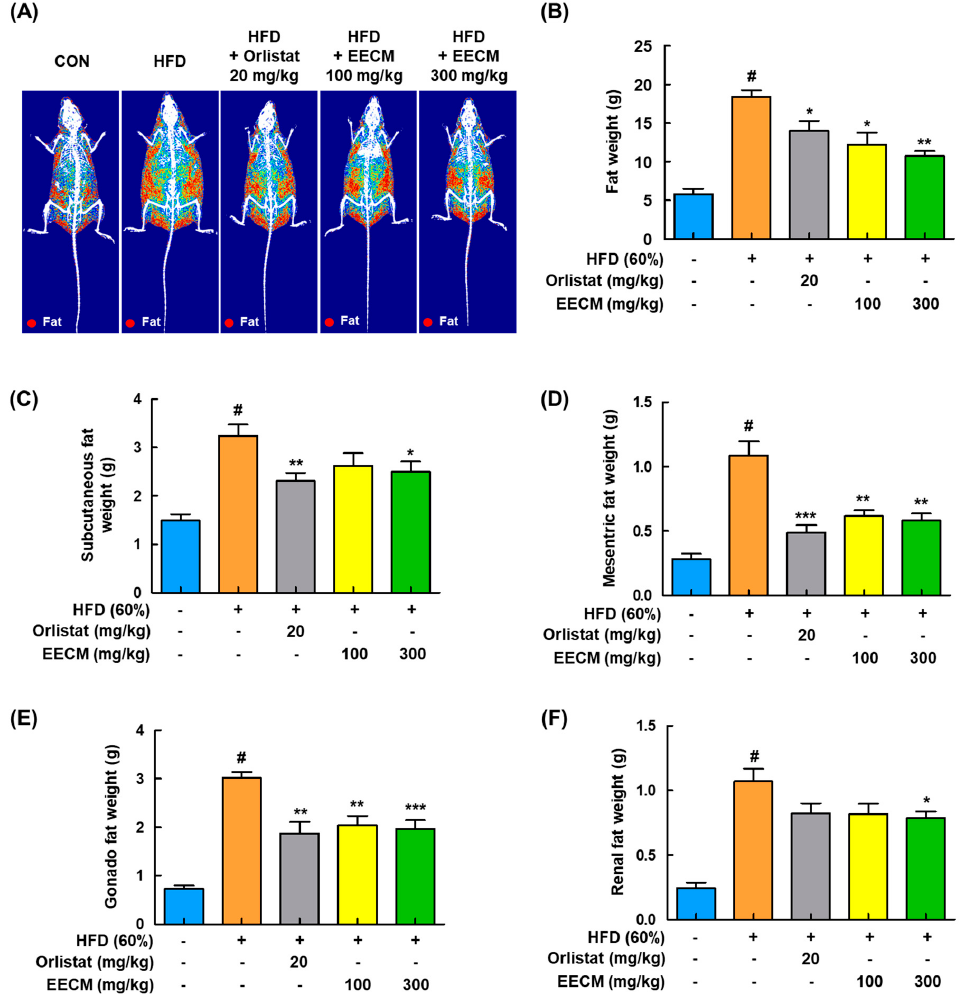
Figure 5. Regulatory effects of EECM on body composition and fat mass in HFD (60%)-induced obese mice. ( A ) Radiography images of the fat tissues are presented. ( B ) Fat weight in each group was measured via DEXA analysis. Fat was obtained from each tissue after the sacrifice of mice, and the weight was measured. ( C – F ) Subcutaneous fat, mesenteric fat, gonadal fat, and perirenal fat weights. Values are represented as the mean ± SEM (DEXA analysis; n = 3/group, fat in tissue weight: n = 8/group). # p < 0.05 vs. the CON group; * p < 0.05, ** p < 0.01, and *** p < 0.001 vs. the HFD (60%)-induced obese group. Table 1. Effects of the ethanol extract of Cassia mimosoides var. nomame Makino (EECM) on the lipid parameters in HFD (60%)-induced obese